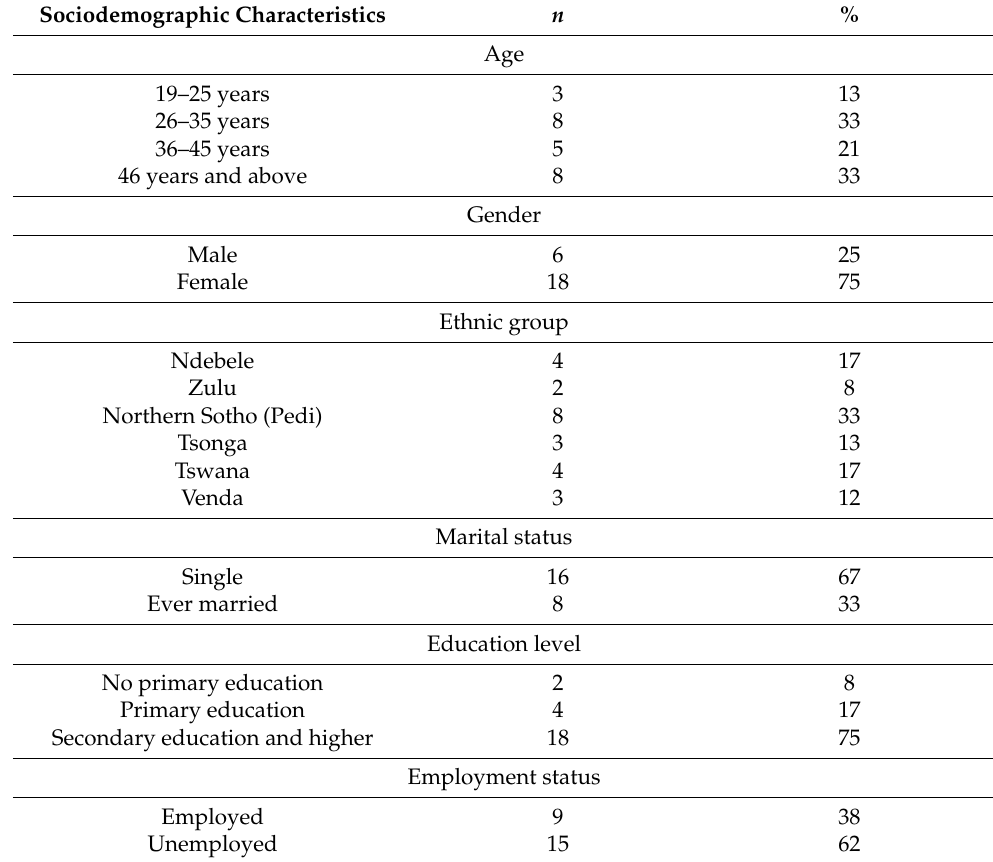
Table 1. Sociodemographic characteristics of the participants ( n =